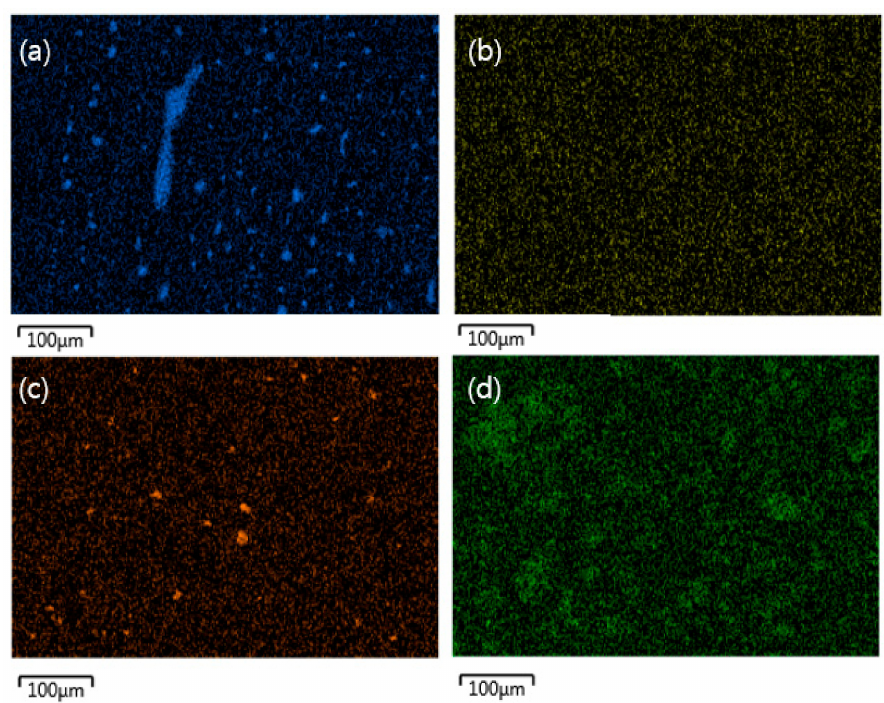
Figure 14. EDS mapping image of the APA surface with different contents of h-BN: ( a ) 10 wt% of untreated h-BN; ( b ) 3 wt%; ( c ) 6 wt%; and ( d ) 10 wt% of surface treated h-BN.